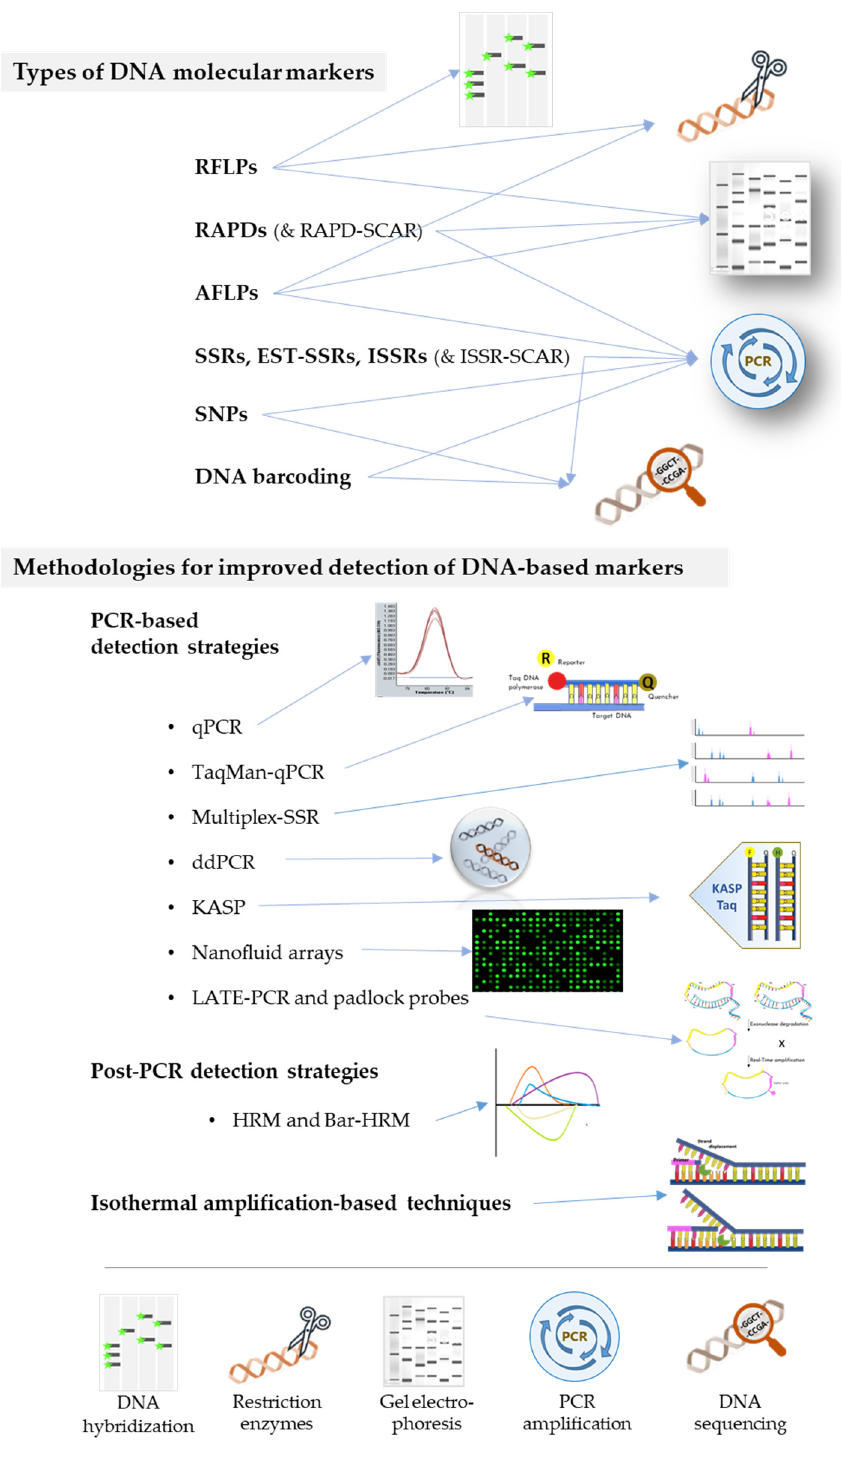
Figure 3. Schematic representation of the most common types of DNA markers used in rice authen- tication, indicating the key methods that characterize each one (legend in the bottom), and some of the methodologies used to improve marker detection.